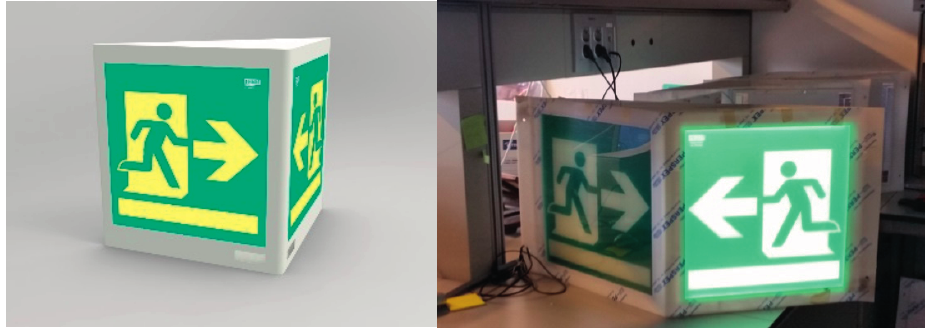
Figure 4. Render and signal